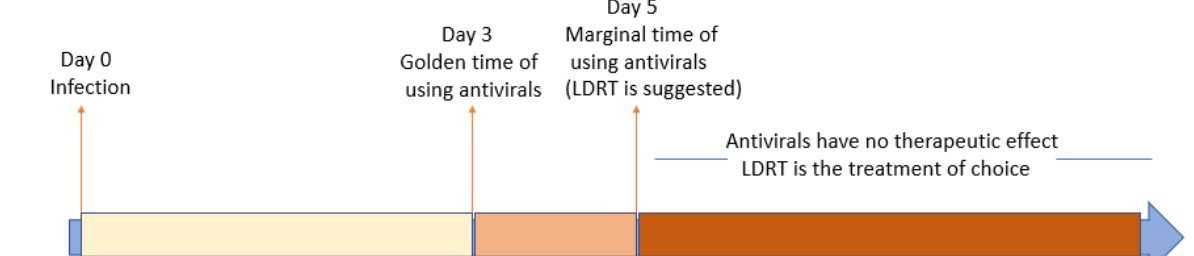
Figure 1. While early use of antivirals (when administered during the golden time window of 72 h post infection) may have a promising outcome and significantly decrease the risk of COVID-19, LDRT becomes a more promising treatment at later stages.